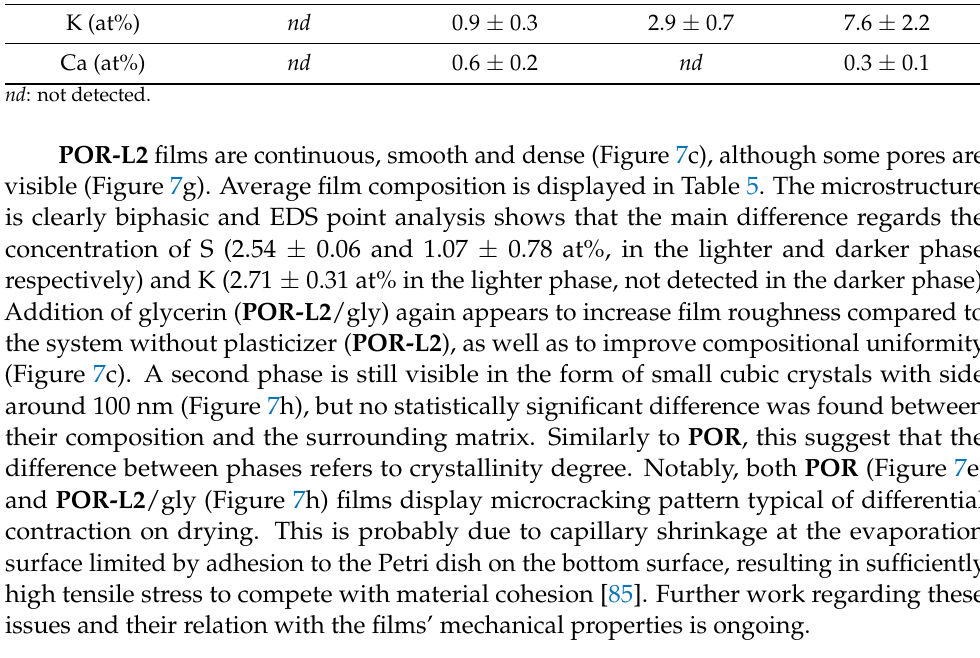
Table 5. Average elemental composition of produced films determined by EDS area analysis. POR POR/gly POR-L2 POR-L2/gly C (at%) 59.2 ± 1.1 45.8 ± 1.2 57.8 ± 2.1 46.9 ± 5.8 O (at%) 38.4 ± 1.6 46.5 ± 3.3 37.8 ± 2.8 39.4 ± 4.9 S (at%) 1.4 ±